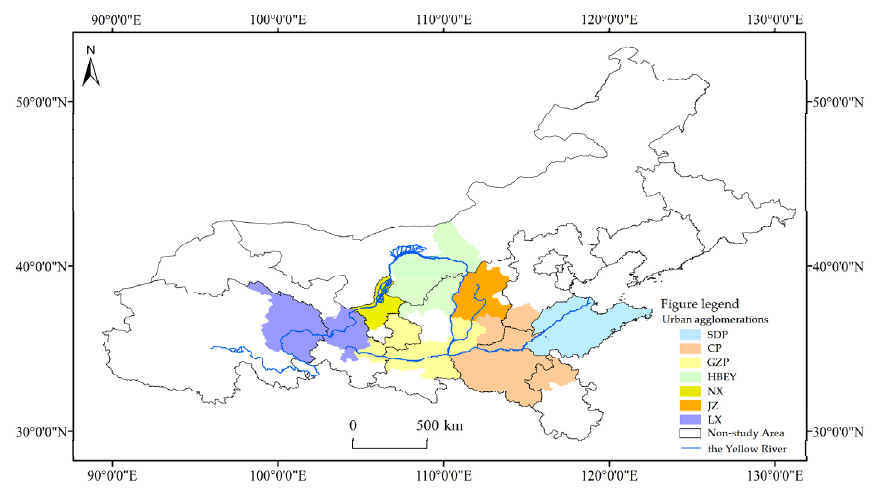
Figure 1. Scope of urban agglomerations in the Yellow River basin.